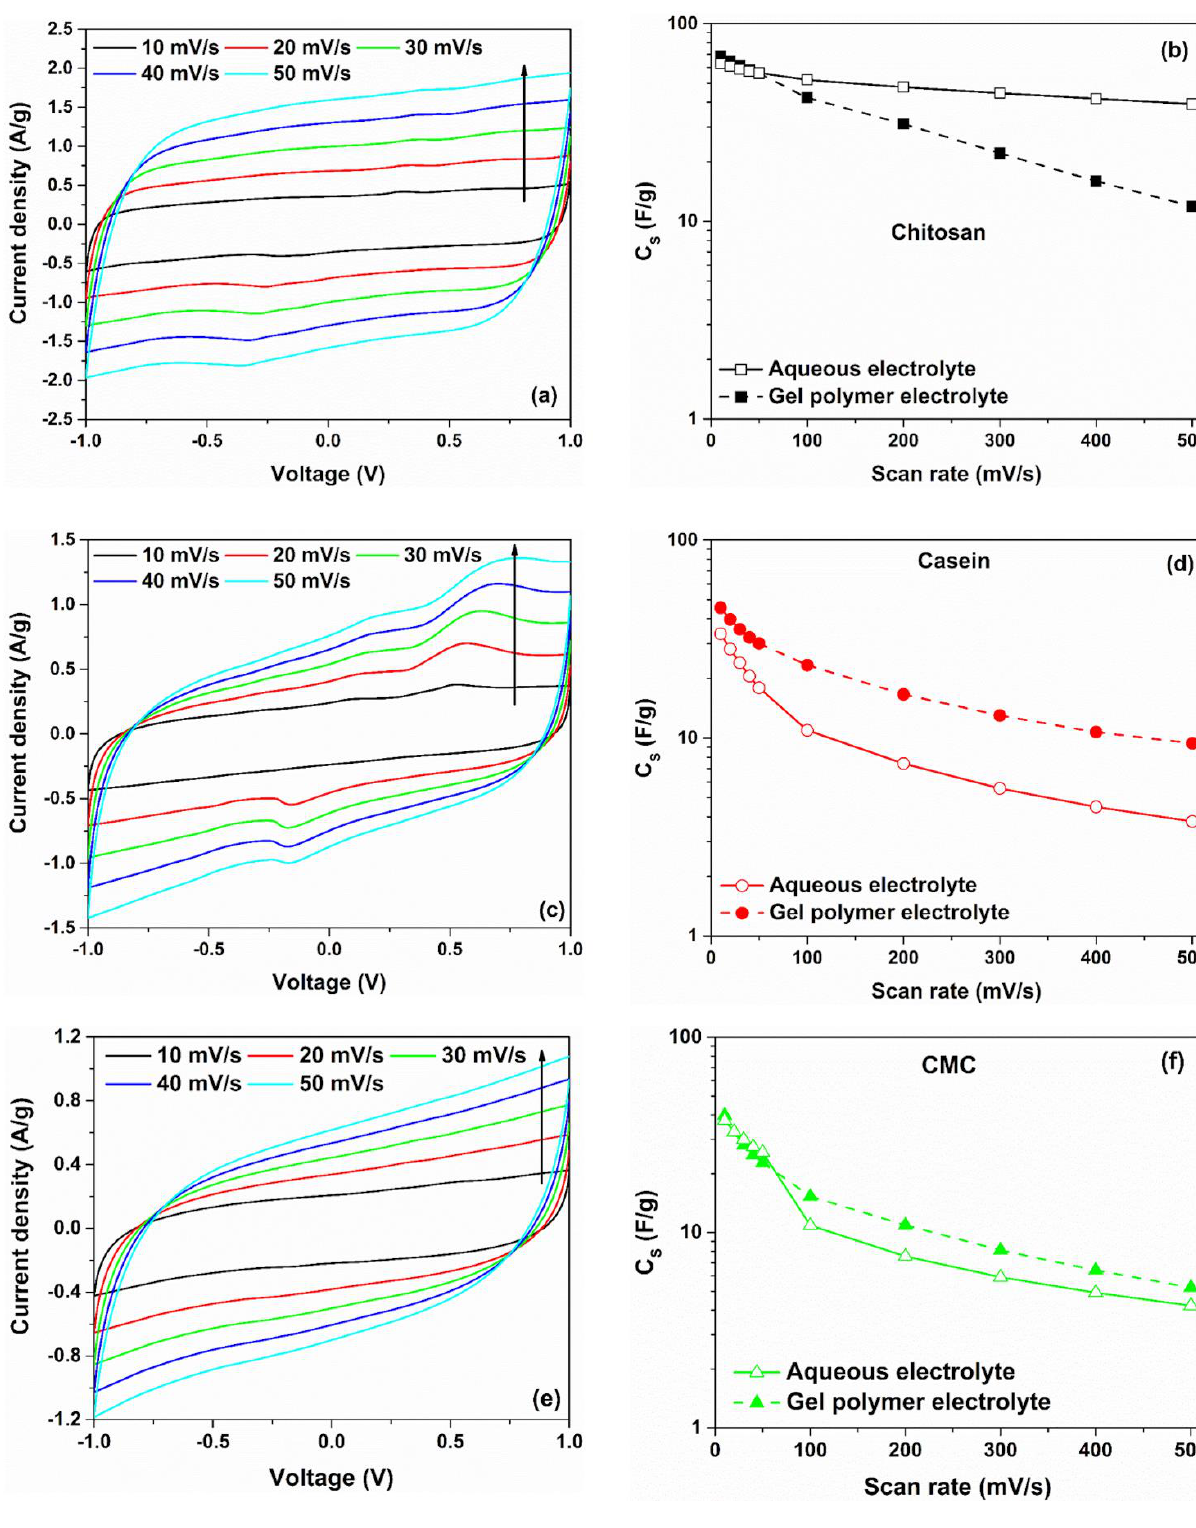
Figure 2. ( a , c , e ) cyclic voltammetry curves of symmetric carbon-based supercapacitors investigated in gel polymer electrolyte 2 M NaCl; ( b , d , f ) comparison of the corresponding gravimetric capacitance values between gel polymer and aqueous-based electrolytes for chitosan, casein and CMC as electrode binder, respectively.